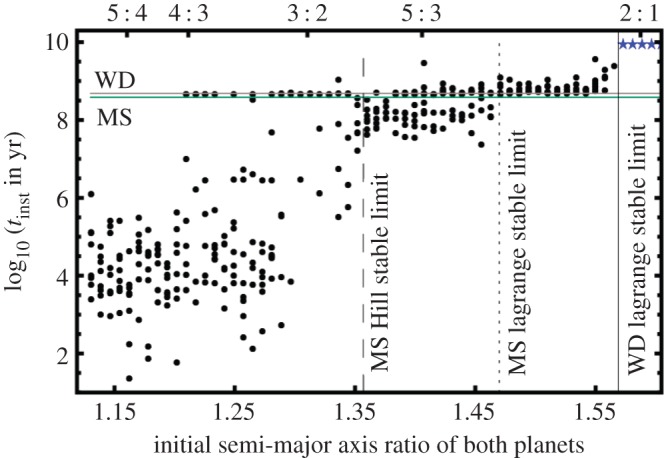
Cosmetically enhanced version of the bottom-rightmost panel of fig. 9 of [24]. I show instability timescales, tinst, as black dots for individual two-planet simulations with the given initial semi-major axis ratio and all with a parent star of M⋆(MS)=3.0 M⊙. Blue stars indicate that all simulations sampled at that particular semi-major axis ratio were stable over a total of 5 Gyr of evolution. The two coloured horizontal lines represent the RGB and AGB phases, and the upper axis illustrates some mean motion commensurabilities. This plot demonstrates that (i) systems which are stable on the MS may become unstable beyond the MS and (ii) that Lagrange instability on the MS can manifest itself late, right before the RGB phase.